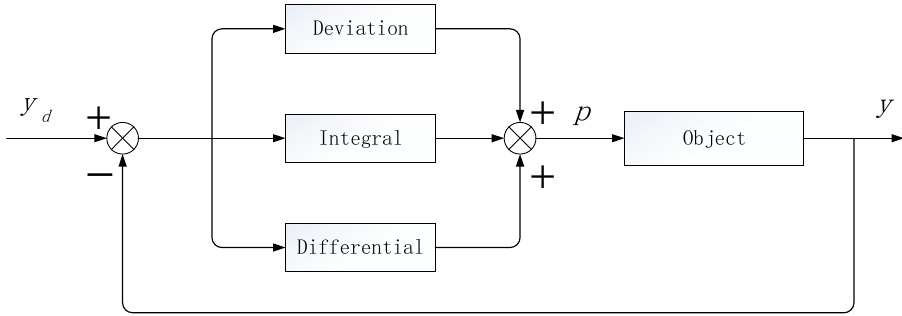
Figure 2. Proportional Integral Derivative (PID) control system schematic diagram.